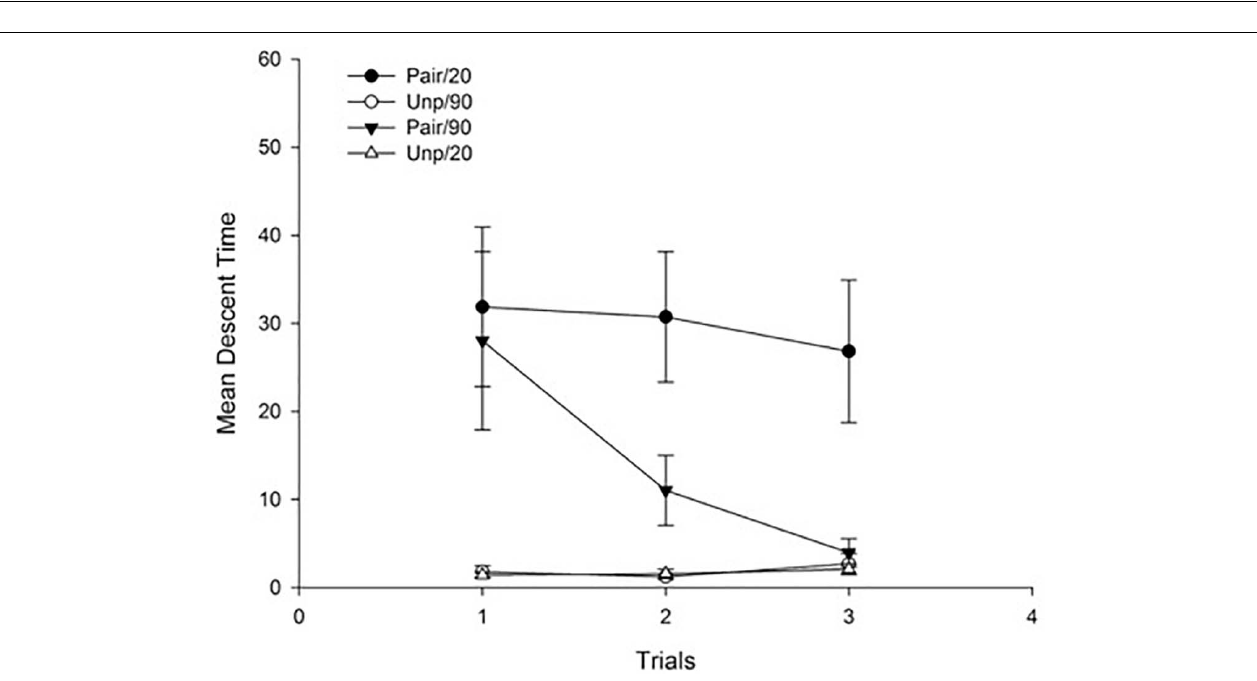
FIGURE 4 | Mean descent latency for drug-free test trials as a function of Groups. Pair: Paired; Unp: Unpaired. Error bars represent SEMs.